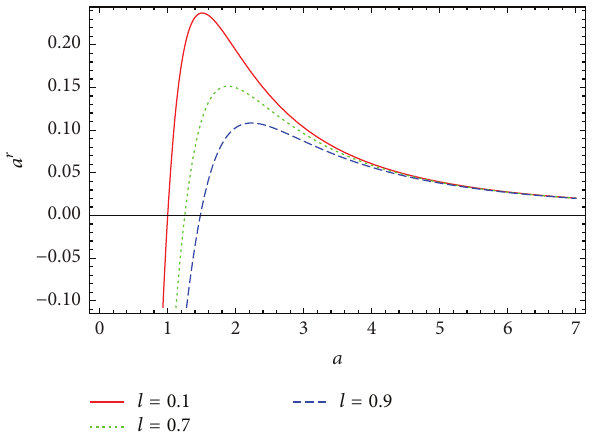
Figure 2: Plots of 𝑎 𝑟 with 𝑀 = 1 and 𝑙 = 0.1, 0.7, 0.9 . The wormhole is attractive for 𝑎 𝑟 > 0 and repulsive for 𝑎 𝑟 < 0